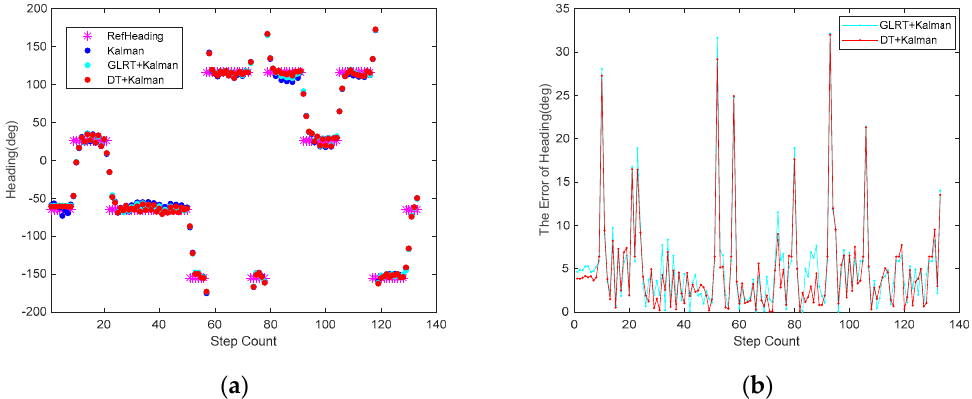
Figure 17. ( a ) Heading calculation of the GLRT+Kalman and DT+Kalman algorithms for indoor pedestrian inertial navigation. ( b ) The error of the heading angle for these two algorithms.